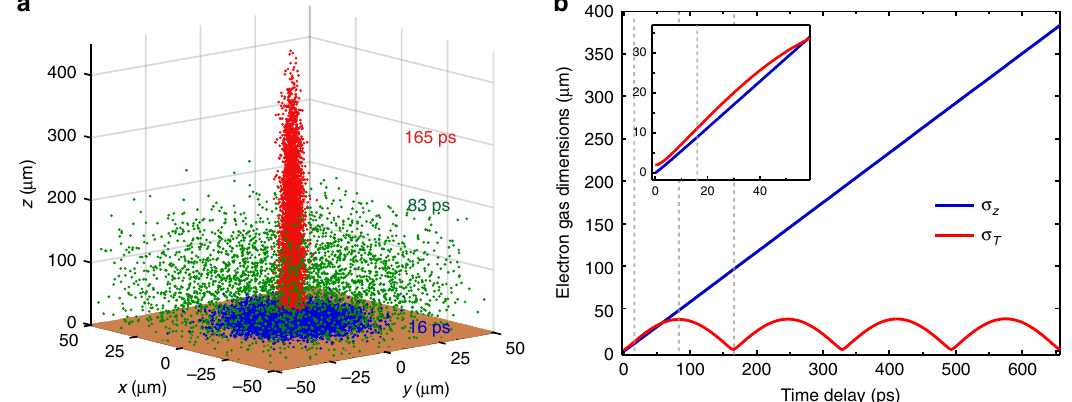
Fig. 8 Results from numerical N-body simulations. a Snapshots of the electron distribution (10,000 electrons) taken at three different time delays. The copper grid is schematically shown in brown. b Electron gas dimensions (standard deviations) in the transverse ( x , y ) and axial ( z ) directions as a function of time, extracted from the N-body simulation with B = 0.22 T. The inset shows a zoom into the dynamics during the fi rst 18 ps. The vertical lines indicate the time delays at which the snapshots in a were